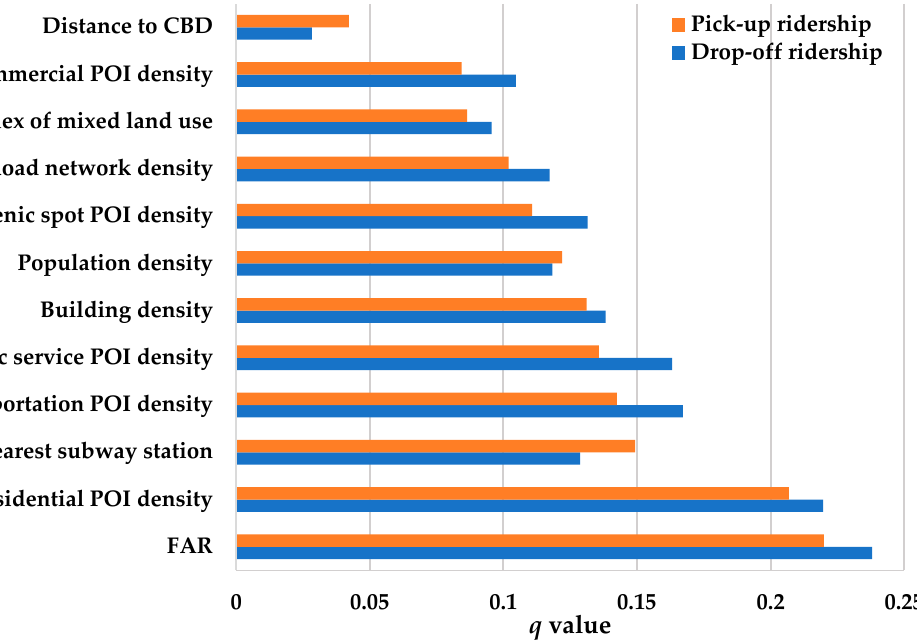
Figure 8. Contribution of single explanatory variables on pick-up and drop-off ridership in the morning peak hours by the factor detector.